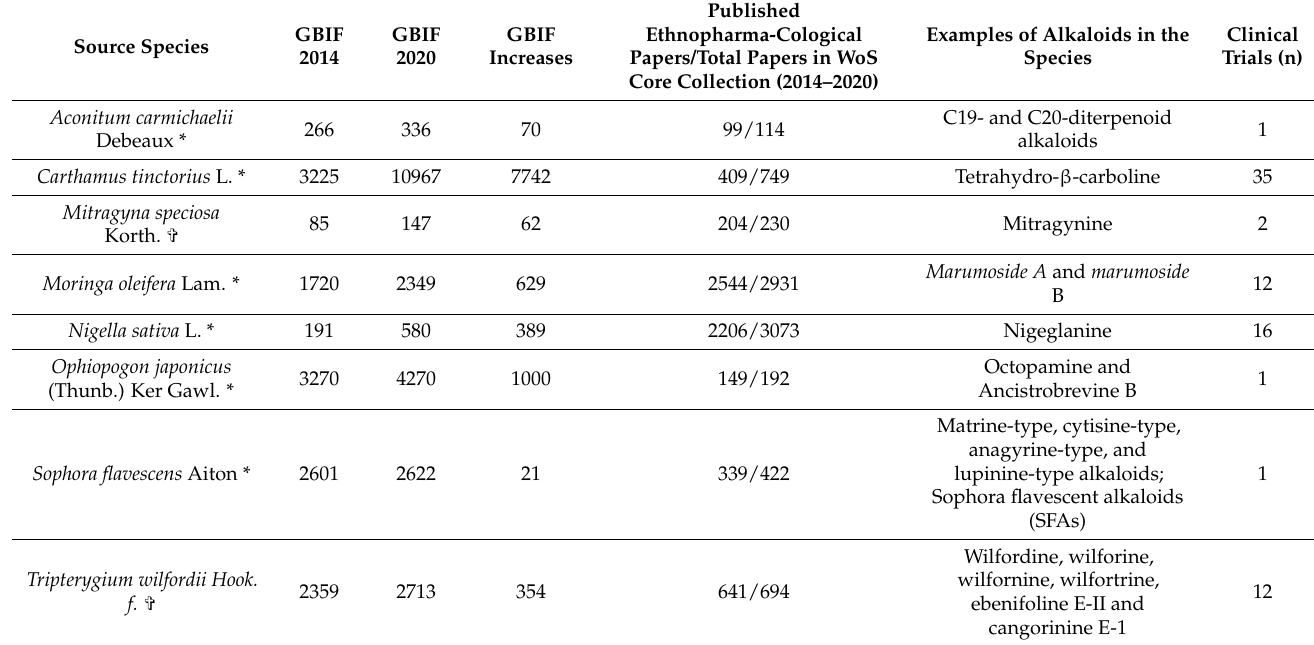
Table 5. Top cited species in the core collection of the Web of Science that contain alkaloids as bioactive compounds between 2014 and 2020 and have had a wider use in traditional medicine. Excluding well established and common staple food plants like Zea mays L., citations are based on Web of Science (WoS) core collections and include the number of times the publication was cited by specific articles from the journals that it covers. *—Very widely cultivated species including as ornamentals usage. (cid:62) —Cultivated to some degree. %—GBIF occurrences indicate a decrease. This is caused by deletion of data by GBIF due to replicates